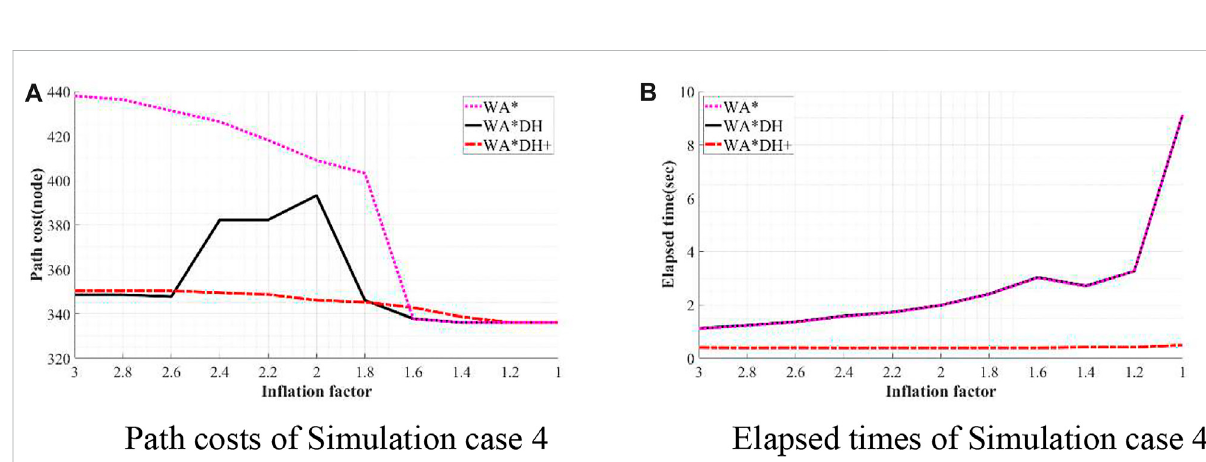
FIGURE 14 Result of simulation case 4. (A) Path costs of simulation case 4. (B) Elapsed times of simulation case